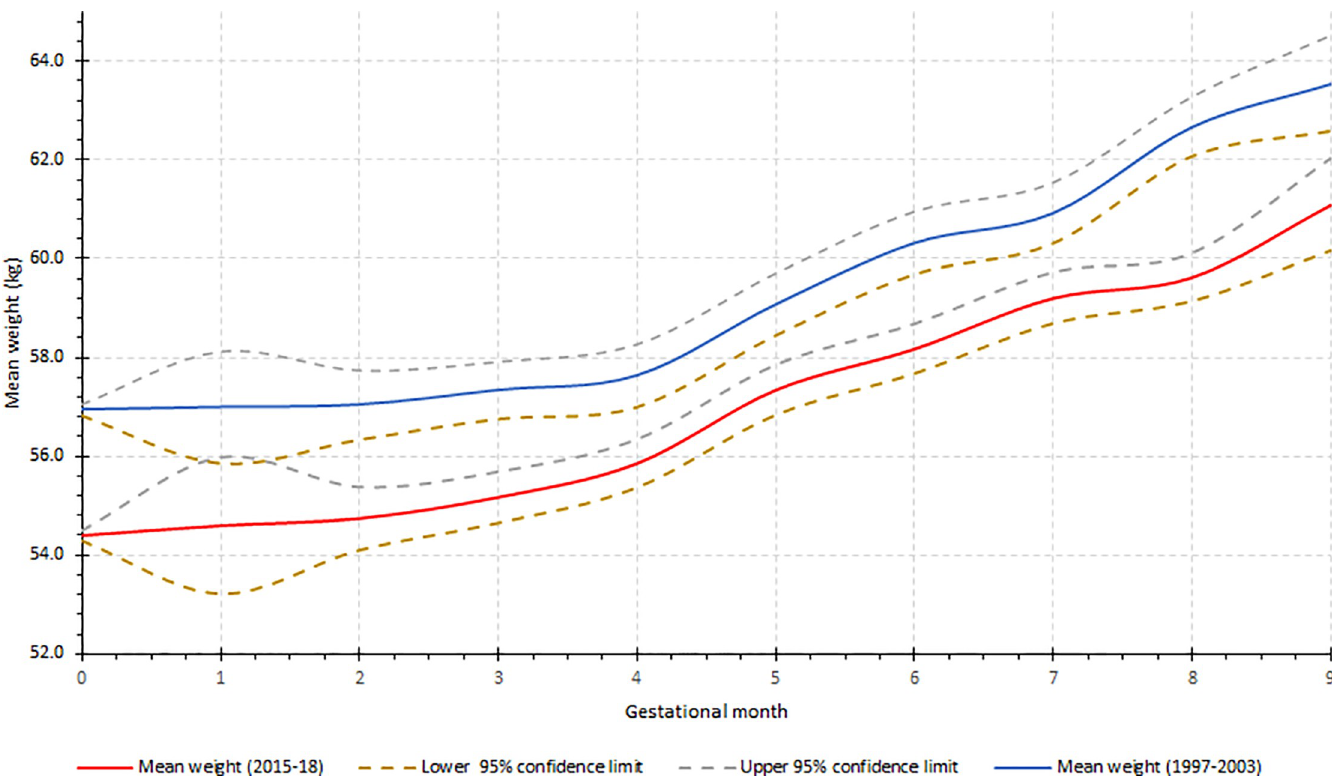
Fig 2. Comparison of gestational weight gain in sub-Saharan Africa between 1997–2003 and after 2014.